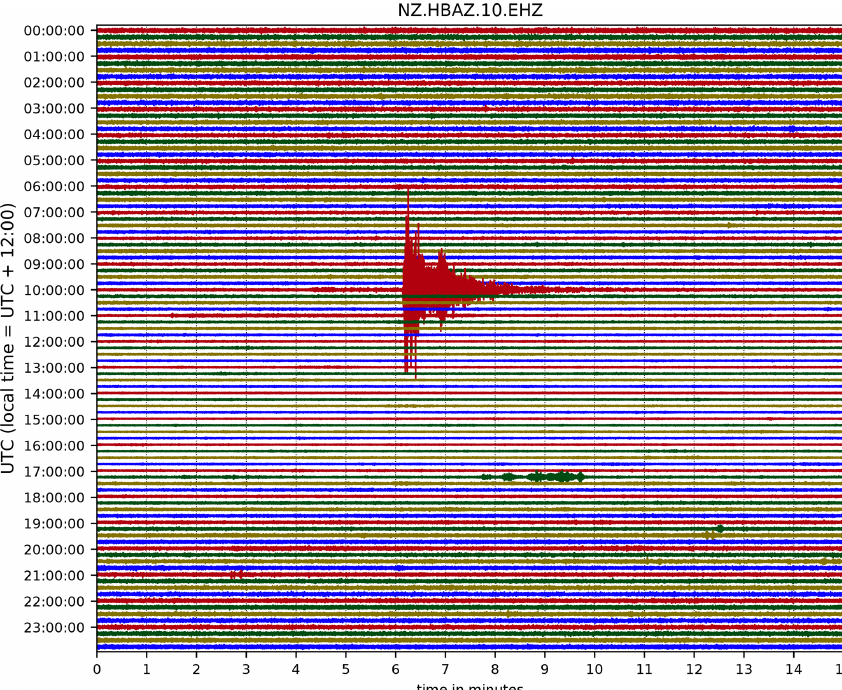
Figure 2. Vertical component of the seismic wavefield at borehole station HBAZ for 14 March 2020. The signal with the largest amplitudes is from an earthquake in the Kermadec Islands region (event ID us60008fl8).